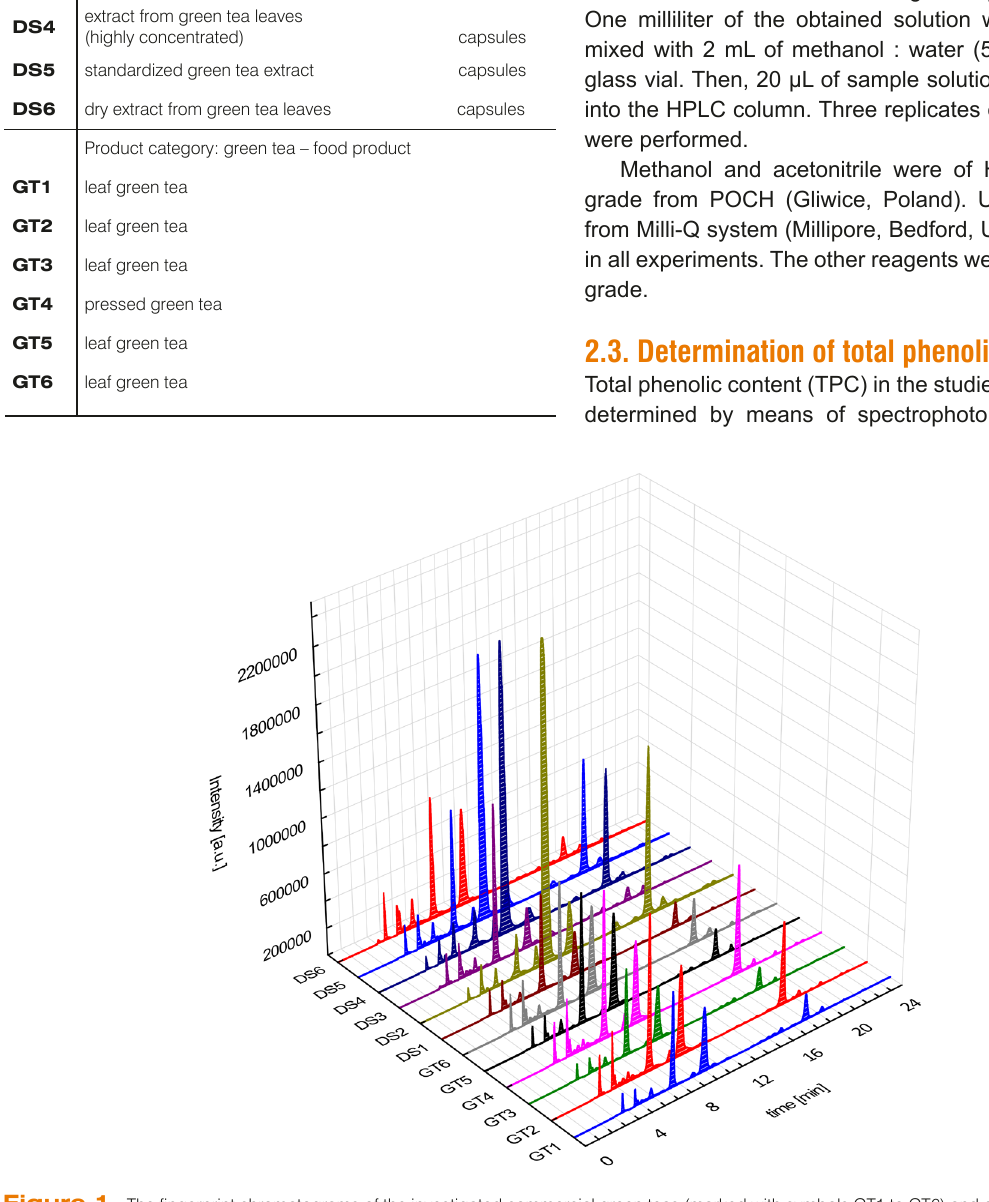
Figure 1. The fingerprint chromatograms of the investigated commercial green teas (marked with symbols GT1 to GT6) and dietary supplements containing Camellia sinensis extract (marked with symbols DS1 to DS6), registered at the wavelength of 270